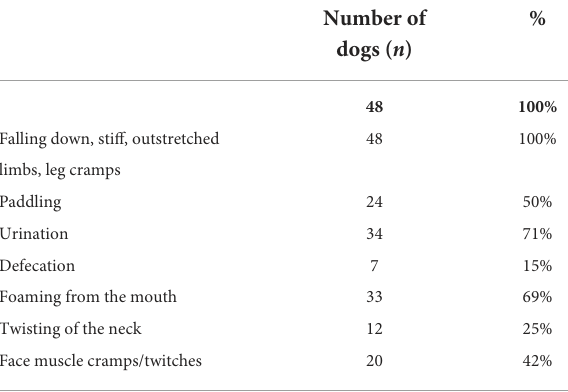
TABLE 2 Most common signs seen during the generalized seizure.